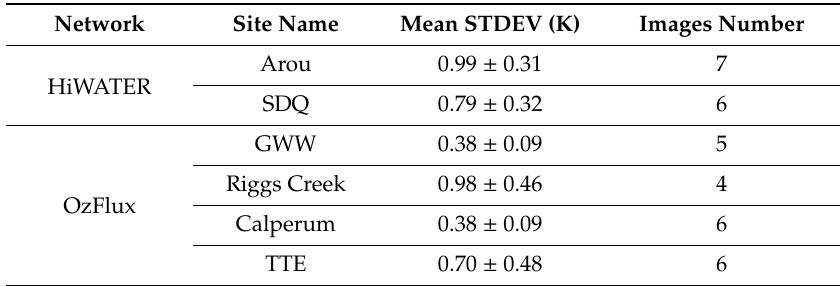
Table 5. The mean values of LST standard deviations within 2 × 2 km 2 Advanced Spaceborne Thermal Emission and Reflection Radiometer (ASTER) pixels from 2013–2019 during the nighttime for the T-based